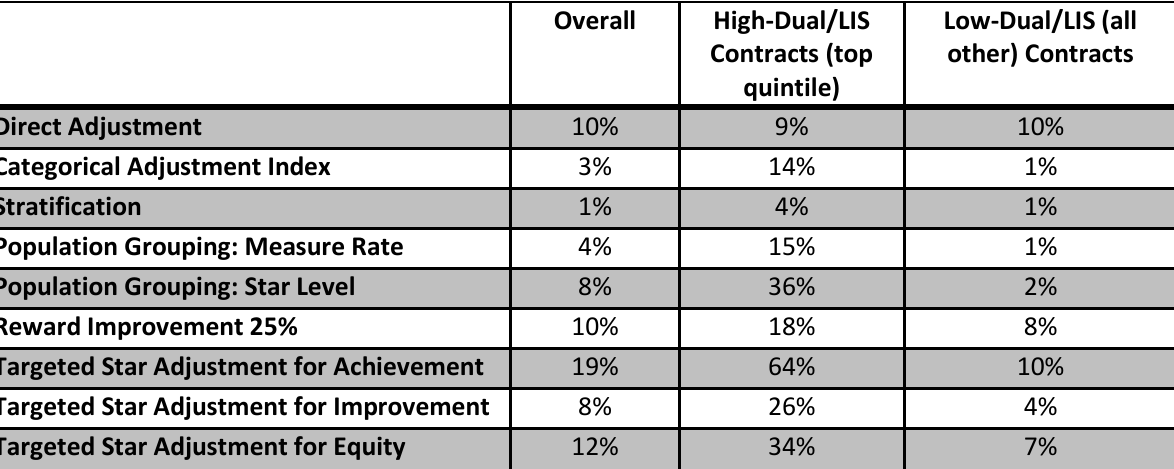
Table 8.18a: Net Impact of Policy Options: Percent of Contracts that Gain at Least Half a